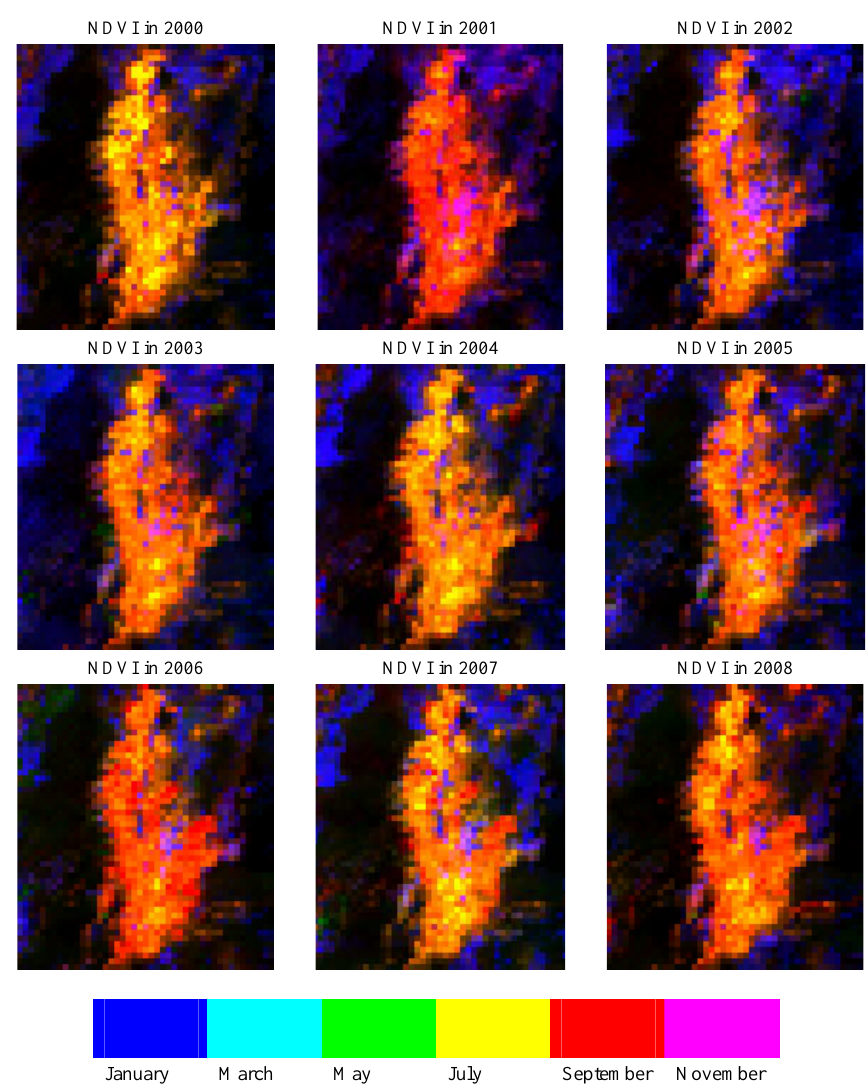
Fig. 12. The IHS color transformed image of the 12-month Fourier harmonic component of NDVI time series from 2000 to 2008 in the Ejina Oasis in the lower reach of the Heihe river basin. “Intensity”=annual mean NDVI, “Hue”=the phase of the 12-month harmonic component, “Saturation”=the amplitude of the 12-month harmonic component.